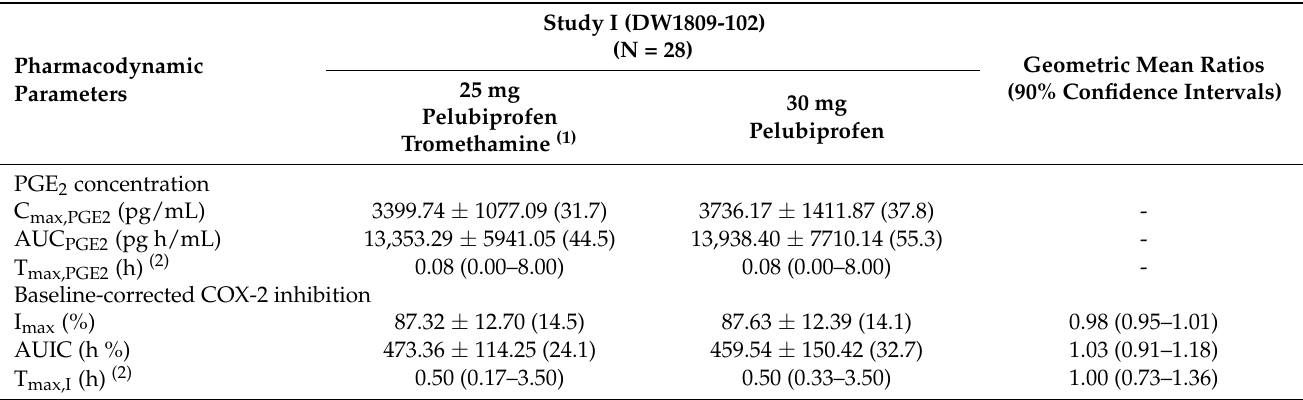
Table 5. The COX-2 inhibition derived from PGE 2 concentration after administration of 25 mg of pelubiprofen tromethamine and 30 mg of pelubiprofen without potential